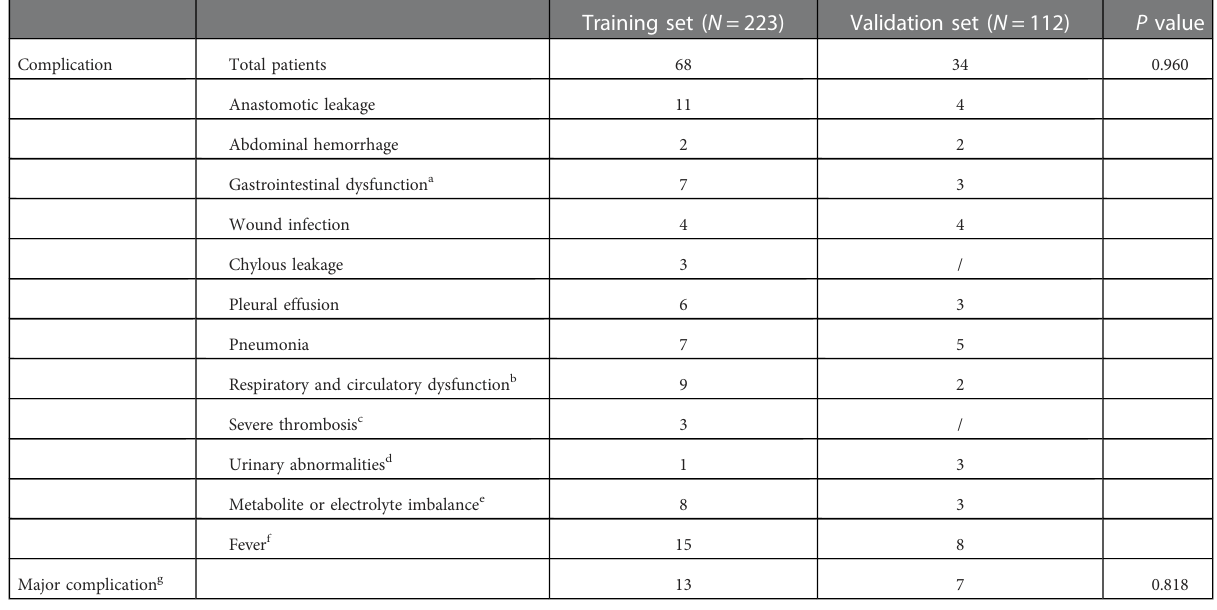
TABLE 2 Display of postoperative complications in the training and validation